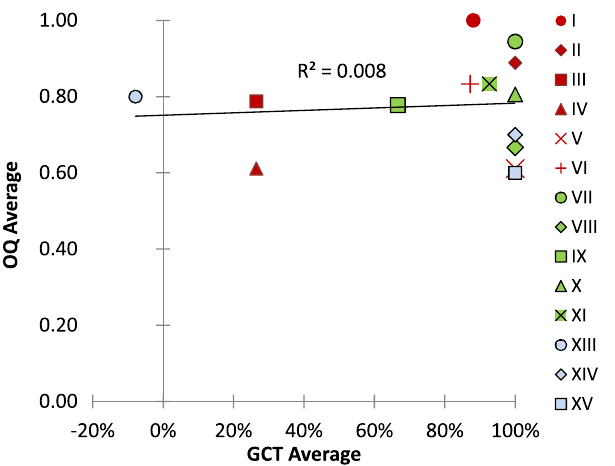
FIG. 7. Average scores on the individual comparison questions for the OQ vs the GCT, with linear regression and corresponding Pearson correlation coefficient ( R 2 ¼ 0 . 008 ). Error bars are not shown for clarity; the average standard error was (cid:2) 8 % for the GCT and (cid:2) 0 . 03 for the OQ.